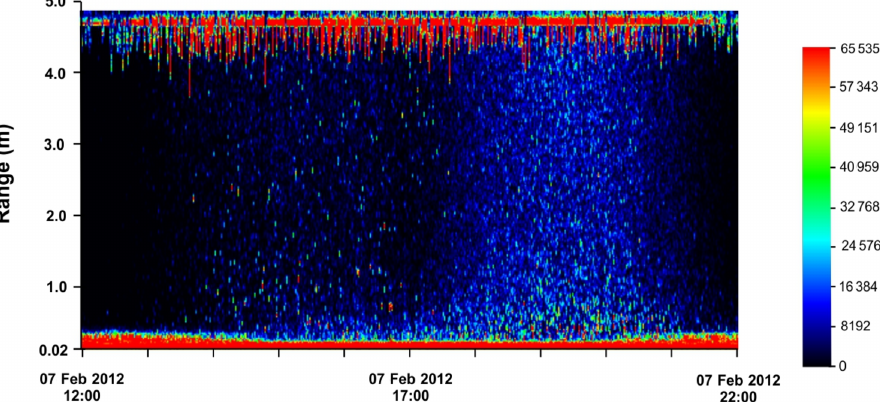
Figure 8. Echogram of the channel 4 (774kHz) returns at times subsequent to the measurements underlying the interval 5 F(t) data in Fig. 2b. The plotted return strengths show that the, roughly, 14:00MST thinning of the close-in feature, indicative of anchor ice clearance, is shortly (15:00 to 17:00MST) followed by both initial appearances of weak frazil returns and small numbers of high-intensity returns, consistent with anchor ice fragments produced by the upstream clearing